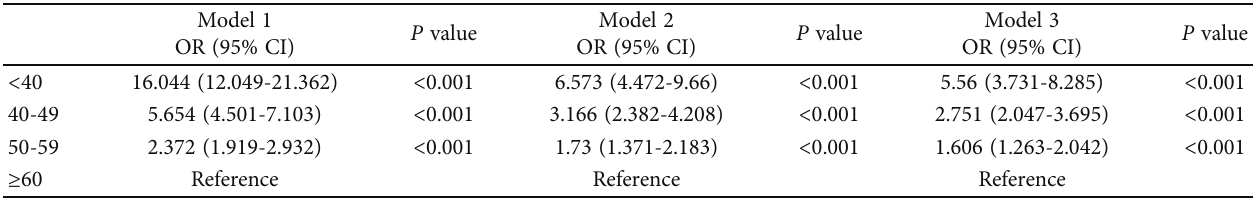
Table 2: Association of the age of diabetes onset with diabetic retinopathy in patients with type 2 diabetes based on multivariate logistic regression